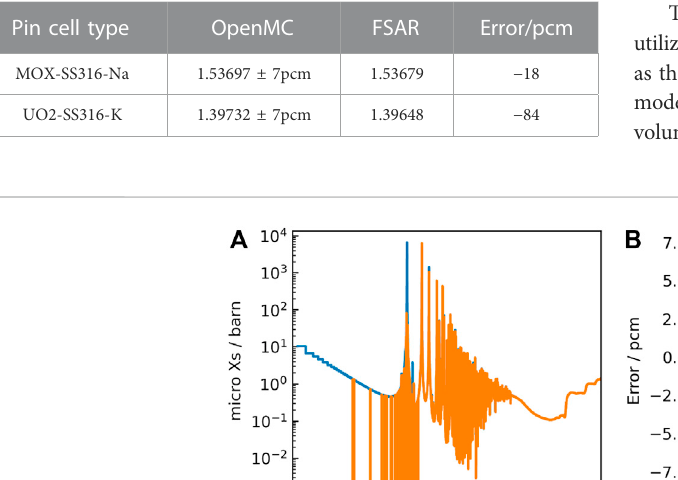
TABLE 3 Fast spectrum problem